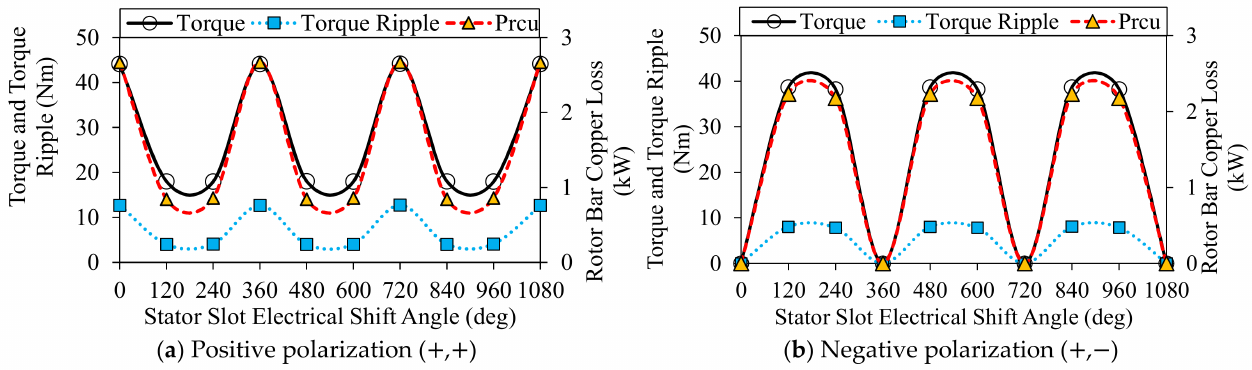
Figure 4. Variation of torque, torque ripple and rotor bar copper loss with α : ( a ) while the both of the winding sets are in ( + ) polarization and ( b ) while the 1.set is in ( + ) and 2.set is in ( − )